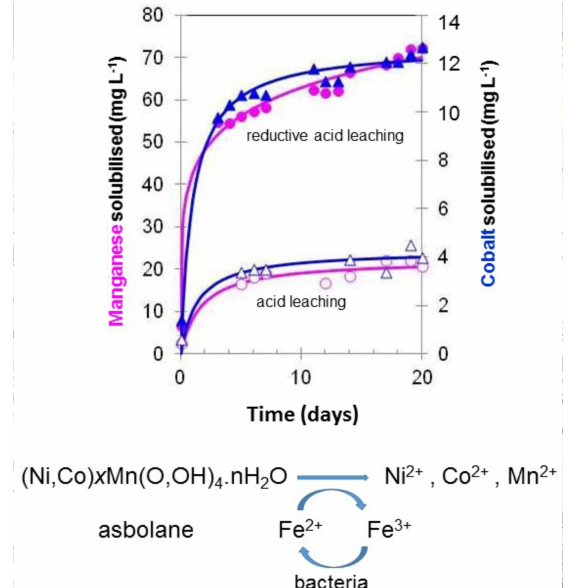
Figure 3. The correlation between cobalt and manganese solubilised from a lateritic ore by reductive mineral dissolution, and comparison of bioleaching under aerobic and anaerobic conditions